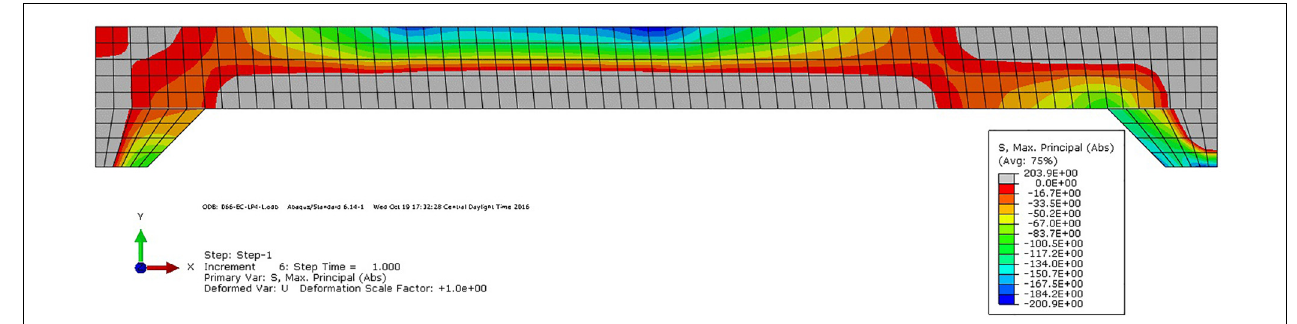
FIGURE 10 | Cross-sectional view of principal stresses due to LP-4-L load configuration (1 inch = 25.4 mm, 1 mm = 0.02